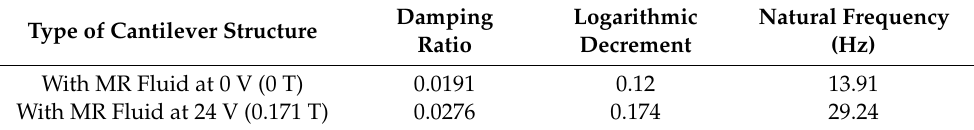
Table 2. Vibration response of different cantilever